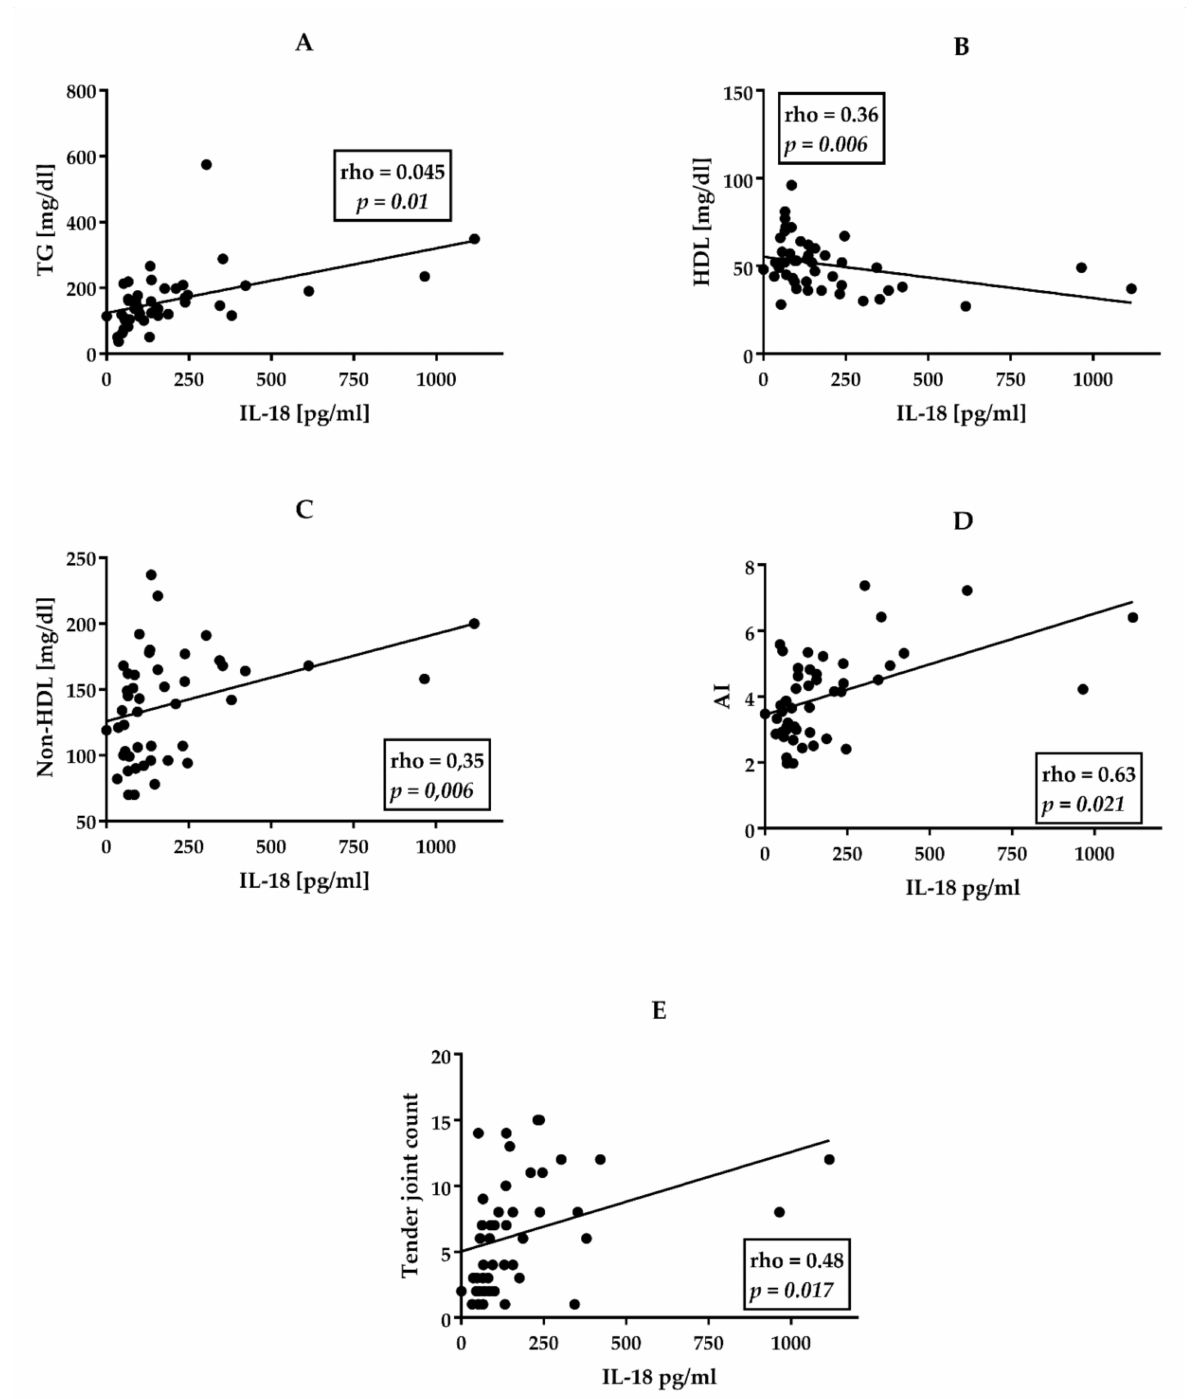
Figure 3. Correlations between IL-18 and lipid profile and TJ in patients with perPsA ( n = 47). ( A ) TG- triglycerides. ( B ) HDL—High-Density Cholesterol. ( C ) Non-HDL-C—Non-High-Density Cholesterol. ( D ) AI—atherogenic index. ( E ) TJ—tender joint count. All correlations were analyzed us- ing Spearman’s rank test. Rho—Spearman’s rank correlation coefficient. p —value for null hypothesis for Spearman’s rank